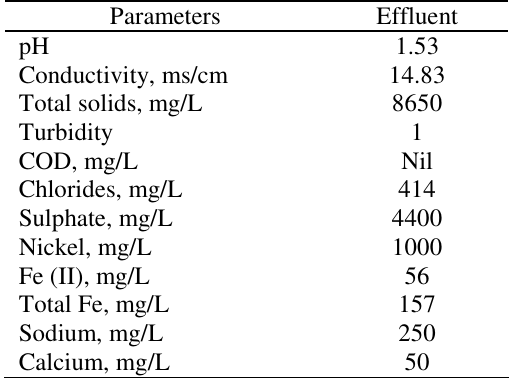
Table 8. Physicochemical characteristics of electroplating industry